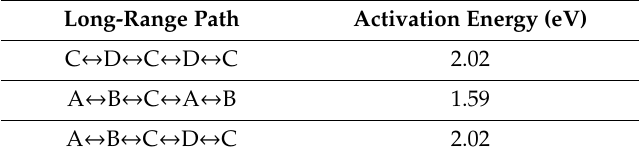
Table 4. Long-range Ca ion di ff usion paths and their activation